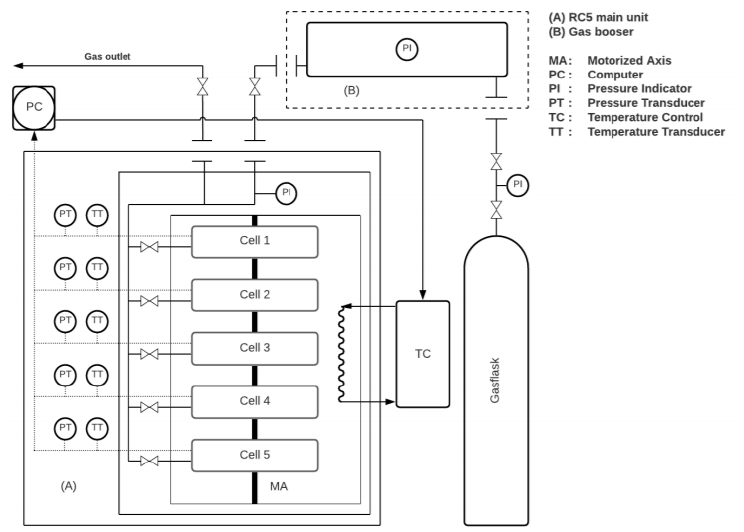
Figure 1. Schematic of rocking cell setup procured from PSL Systemtechnik,